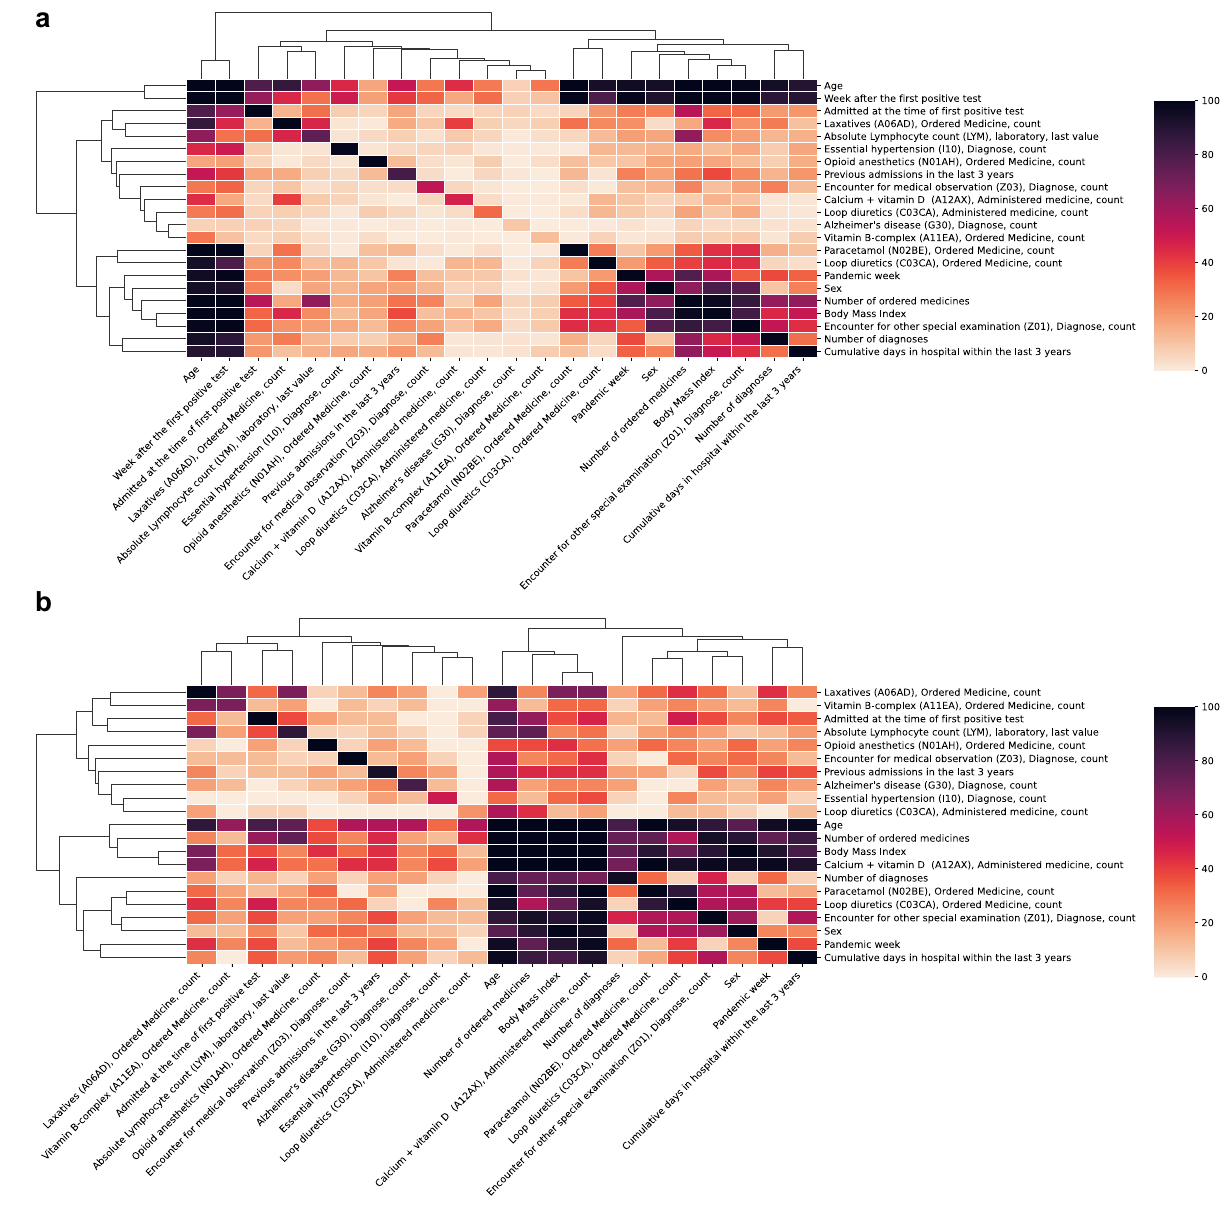
Figure 6. Summary of relevant feature interactions in explaining early and late mortality in SARS-CoV-2 positive patients. For each patient that died within 12 weeks, the SHAP interaction values between all 22 features were calculated. Only interaction values with an absolute value greater than 0.01 were considered relevant and counted. Counts were averaged across all patients to show the percentage rate a given pair of features was relevant. The diagonal represents the percentage of patients for which each feature had a SHAP value higher than 0.01. ( a ) Shows relevant feature interactions for patients who died within 4 weeks and for those who died between 8 and 12 weeks ( b ) thus visualizing the difference in feature interactions for early and late mortality in SARS-CoV-2 positive patients. In both heatmaps, features were ordered by hierarchical clustering using Euclidean distance as the metric for average